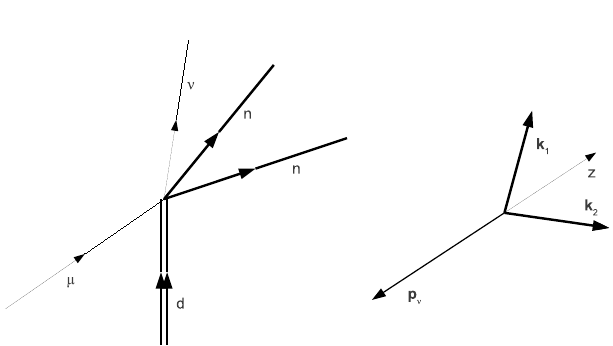
Figure 1: Diagrammatic representation and kinematics for the μ + d → ν μ + n + n reaction. This process is treated as the decay of the muonic atom, with the muon on the K